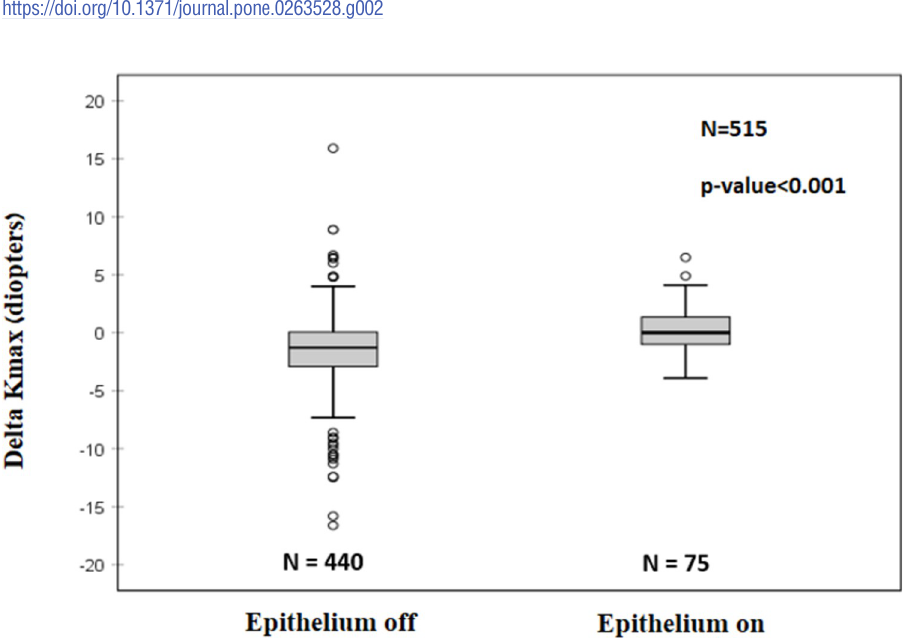
Fig 3. Delta Kmax 1 with epithelium-off and epithelium-on CXL 2 protocols. Paired t-test showed significantly more mean negative Delta Kmax value with the epithelium-off protocol (P < 0.001), indicating a greater efficacy for the epithelium-off compared with the epithelium-on protocol. 1 Delta Kmax = (maximal corneal power after cross- linking)–(maximal corneal power before cross-linking). 2 CXL = Cross-linking.